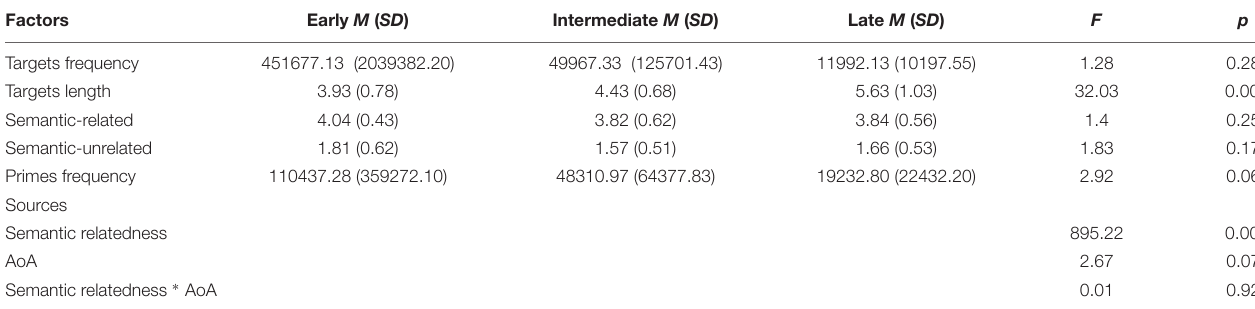
TABLE 2 | The ANOVA results of matched factors for targets and